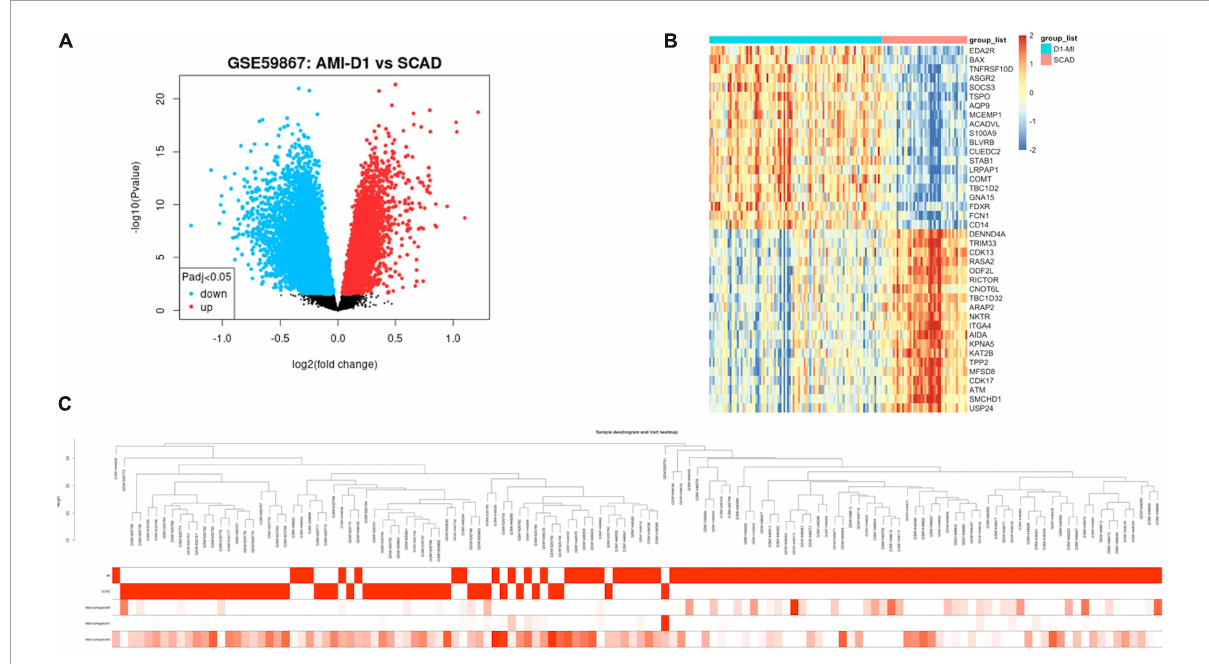
FIGURE2 Expression profile of differentially expressed genes (DEGs). (A) Volcano map of gene expression levels. (B) Heatmap of top 20 up-regulated or down-regulated DEGs based on p -value. (C) Clinical feature heatmap and hierarchical clustering dendrogram of AMI or SCAD samples. The clinical characteristics heatmap represented by degree from dark red to white recognizes high to low levels of clinical characteristics, while gray indicates unavailable data.